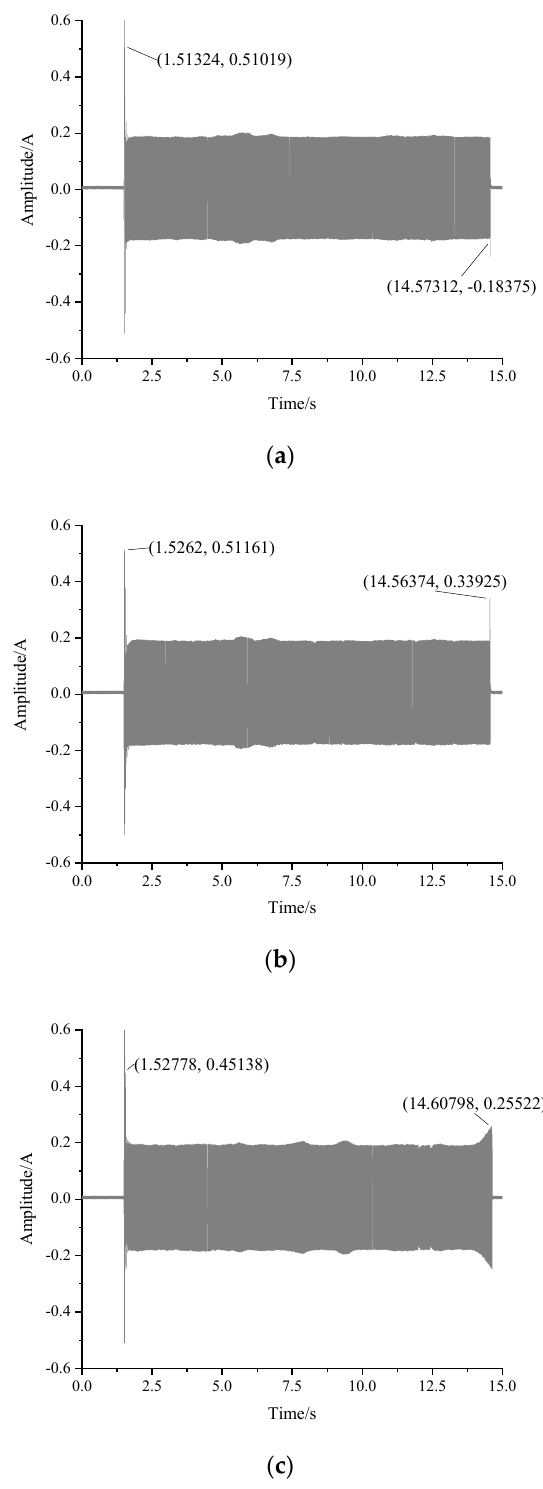
Figure 1. ( a ) Stator fundamental current of the motor under nominal operating conditions. ( b ) Stator fundamental current of the motor when the auxiliary switch screw is loosened. ( c ) Stator fundamental current of the motor when the transmission mechanism is jammed.